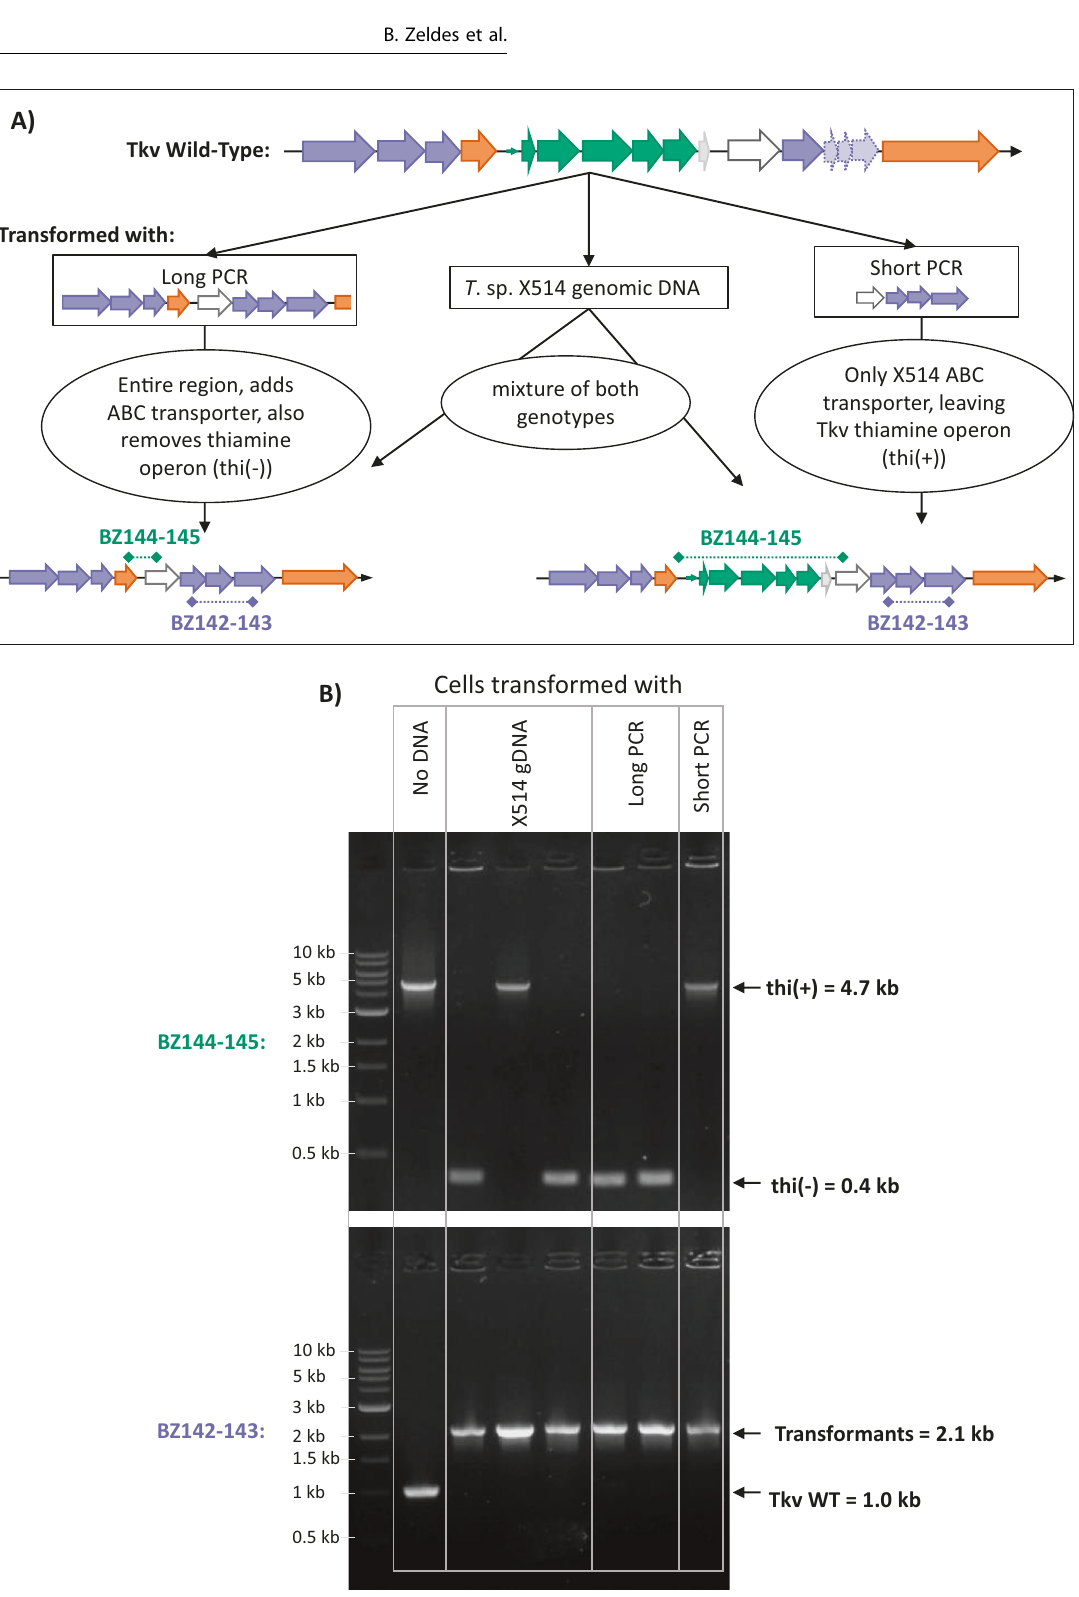
Fig. 4 Reproduction of the HGT by transforming T. kivui with Thermoanaerobacter sp. X514 gDNA, or PCR products of the trehalose region. A The transformation scheme displaying original genomic DNA region, the PCR products used, and resulting transformants. B PCR screening transformed colonies picked off of selective (trehalose containing) agar plates. The upper gel screens for the presence (4.7 kb) or absence (0.4 kb) of the native T. kivui thiamine operon with primers BZ144 and BZ145, while the lower gel screens for presence of the full length X514 trehalose genes (2.1 kb) or truncated T. kivui genes (1.0 kb) with primers BZ142 and BZ143. Marker is NEB 1 kb